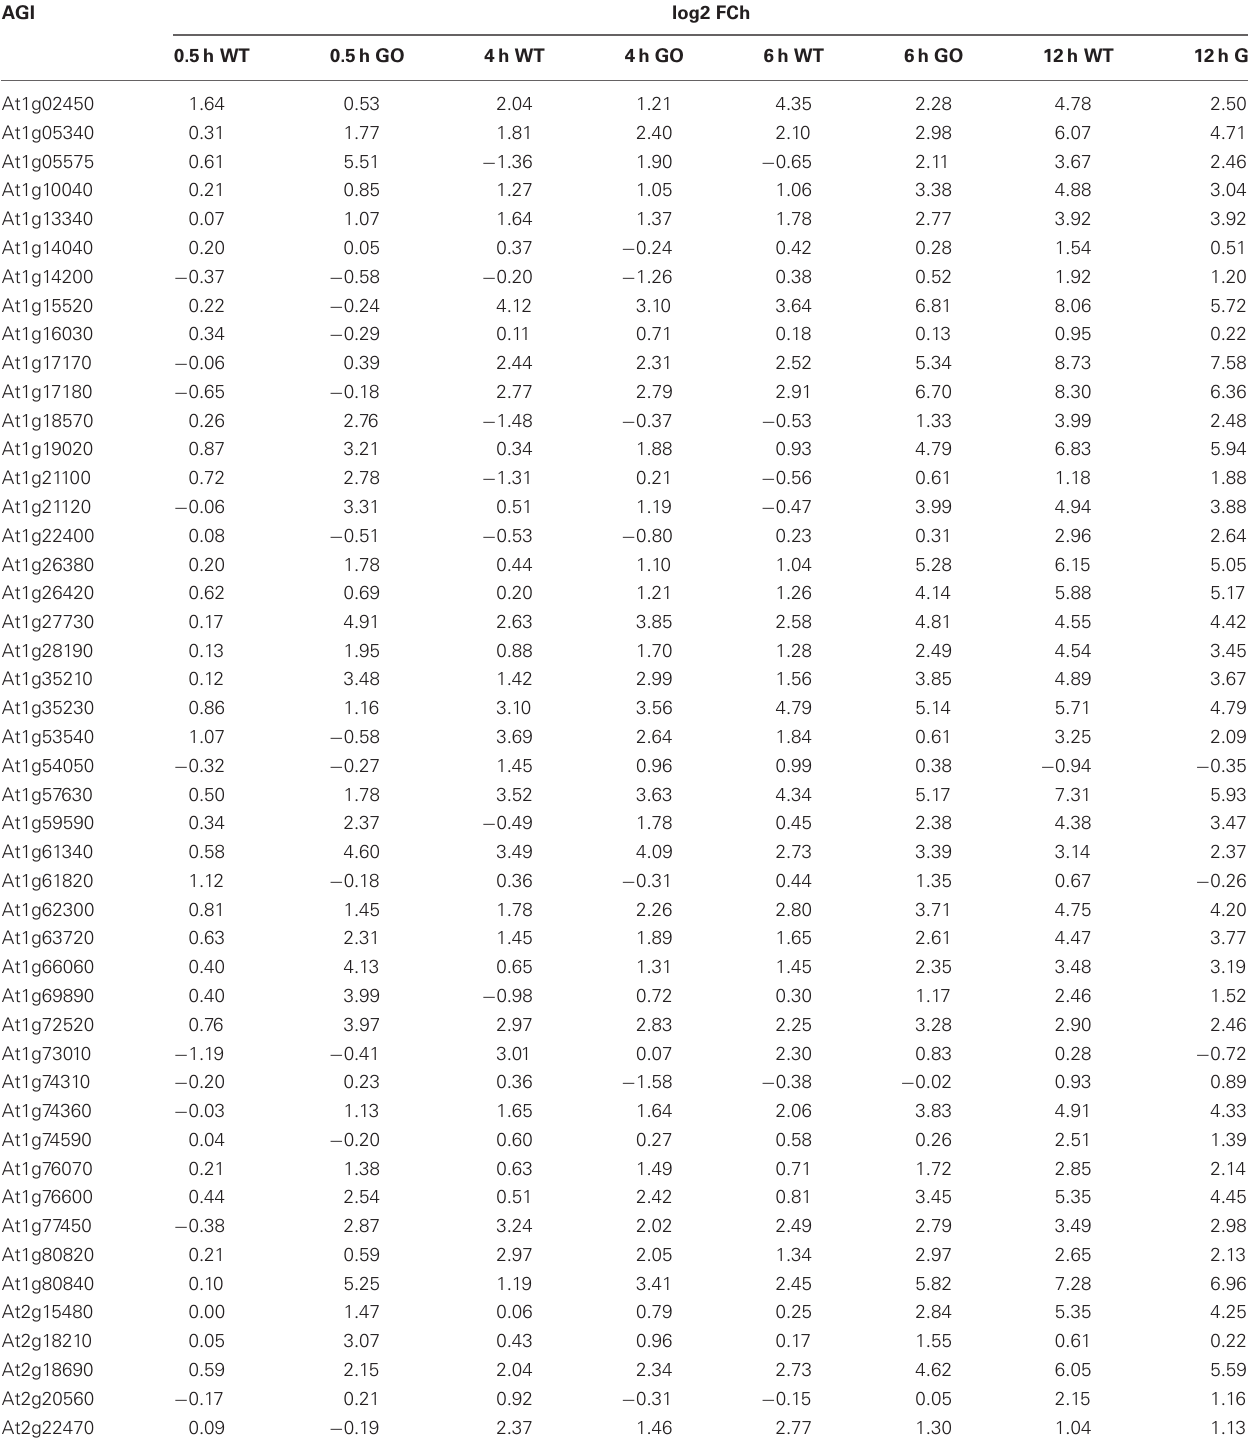
Table A1 | Expression profile of 131 ROS-responsive genes in wild-type (WT) and GO plants after transferring seedlings to ambient CO 2